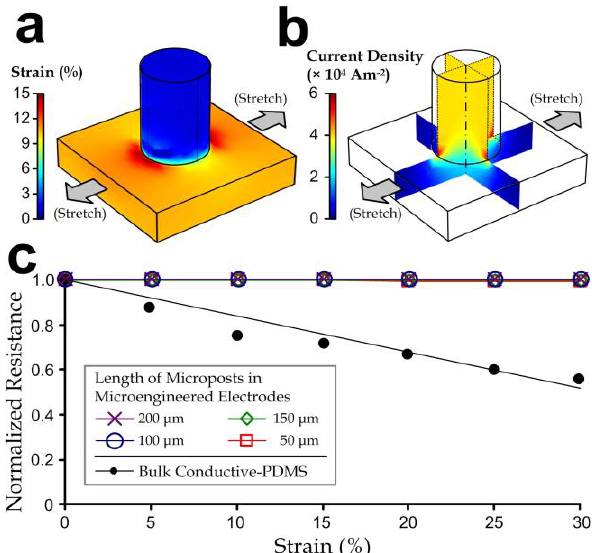
Figure 3. ( a ) Strain profiles; ( b ) Current density profiles of a representative microengineered conductive-PDMS electrode with a micro-pillar half-height of 400 μm at a 10% uniaxial stretch; ( c ) Normalized resistance of bulk conductive-PDMS and microengineered electrodes with different micro-pillar heights as functions of